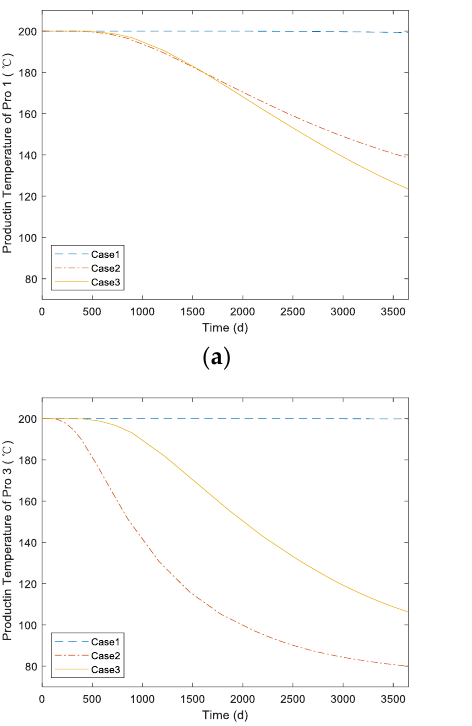
( d ) Figure 17. The flow rate of the production well ( a ) Pro1 ( b ) Pro2 ( c ) Pro3 ( d ) Pro4. 4. Conclusions and Future Work